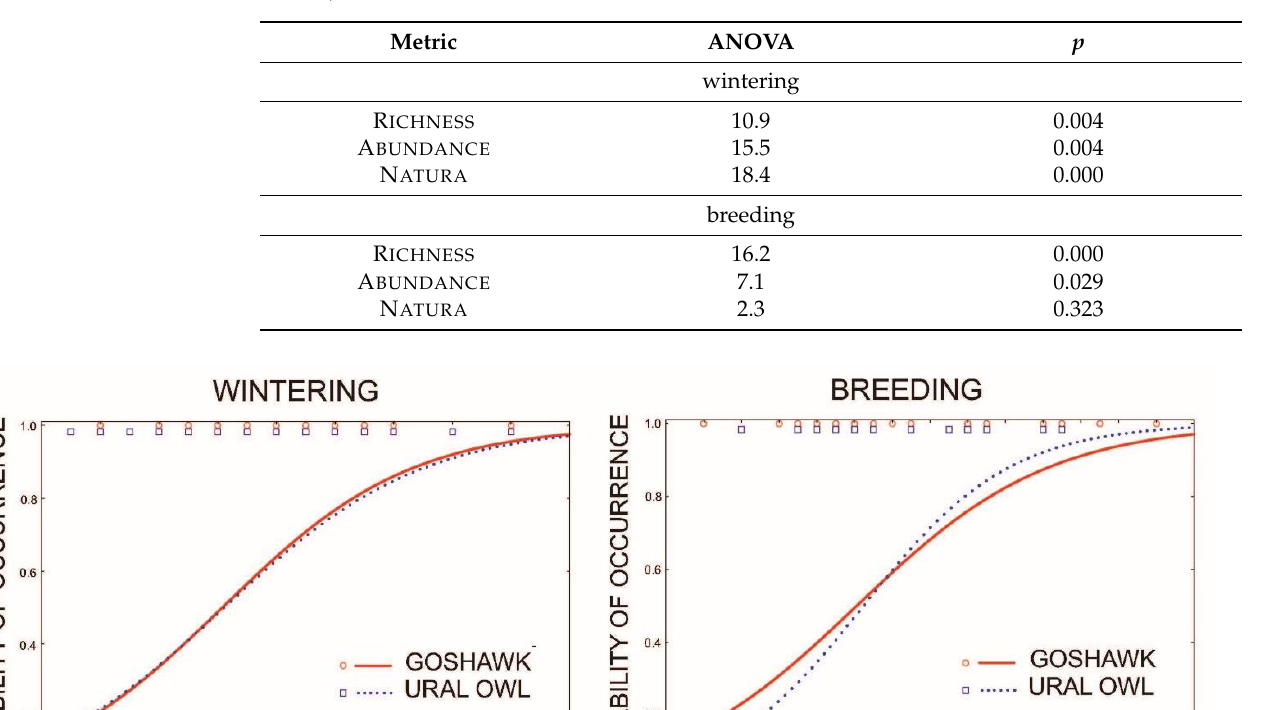
Table 2. Analysis of Variance calculated among all defined groups of plots (goshawk vs. Ural owl vs. control).